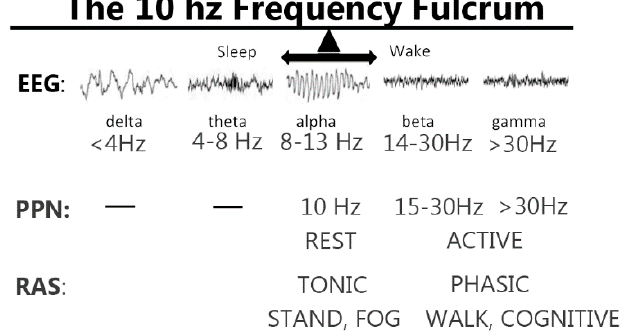
Figure 4. Potential differential effects of PPN deep brain stimulation (DBS). The top row shows examples of EEG recordings during sleep versus waking, with delta (<4 Hz) frequencies occurring during deep slow wave sleep, theta (4–8 Hz) frequencies during light sleep, alpha (8–13 Hz) at the transition between sleep wand waking, beta (14–30 Hz) during waking, and gamma (>30 Hz) during waking. Given the fact that PPN cell activity is ~10 Hz at rest, stimulation at this frequency may have effects related to more tonic activation, including standing and the presence or absence of freezing of gait (FOG). On the other hand, PPN cell activity during active waking is at gamma frequencies, such that stimulation at gamma frequencies may be more related to active processes related to locomotion and arousal.